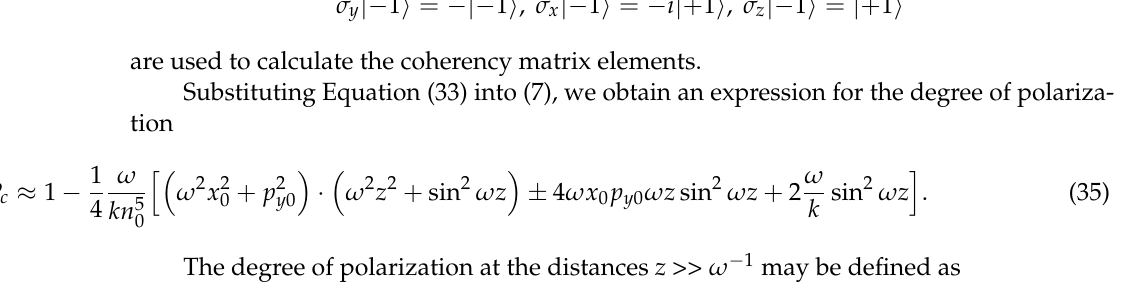
= − − , ˆ are used to calculate the coherency matrix elements.